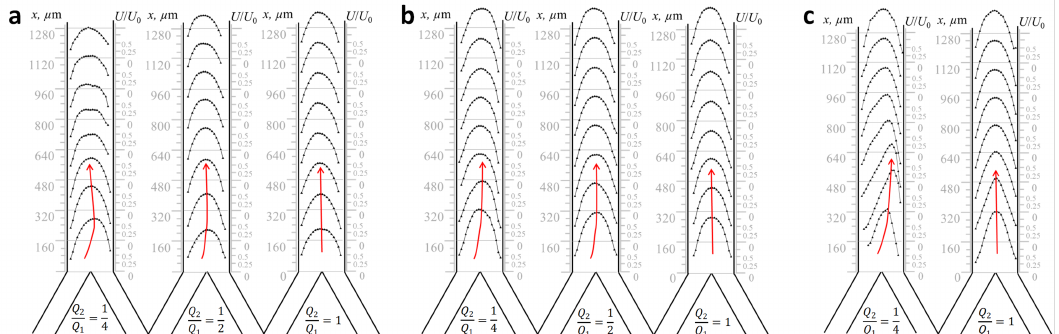
Figure 4. Longitudinal component of the average flow velocity in prototype “Y-type xylem vascular connection” resulted from different ratios of inlet flow rates and equal total flow rate in the outlet channel. ( a ) Re = 3 equaled to 0.1 mm per second; ( b ) Re = 10 equaled to 0.25 mm per second; ( c ) Re = 47 equaled to 1.2 mm per